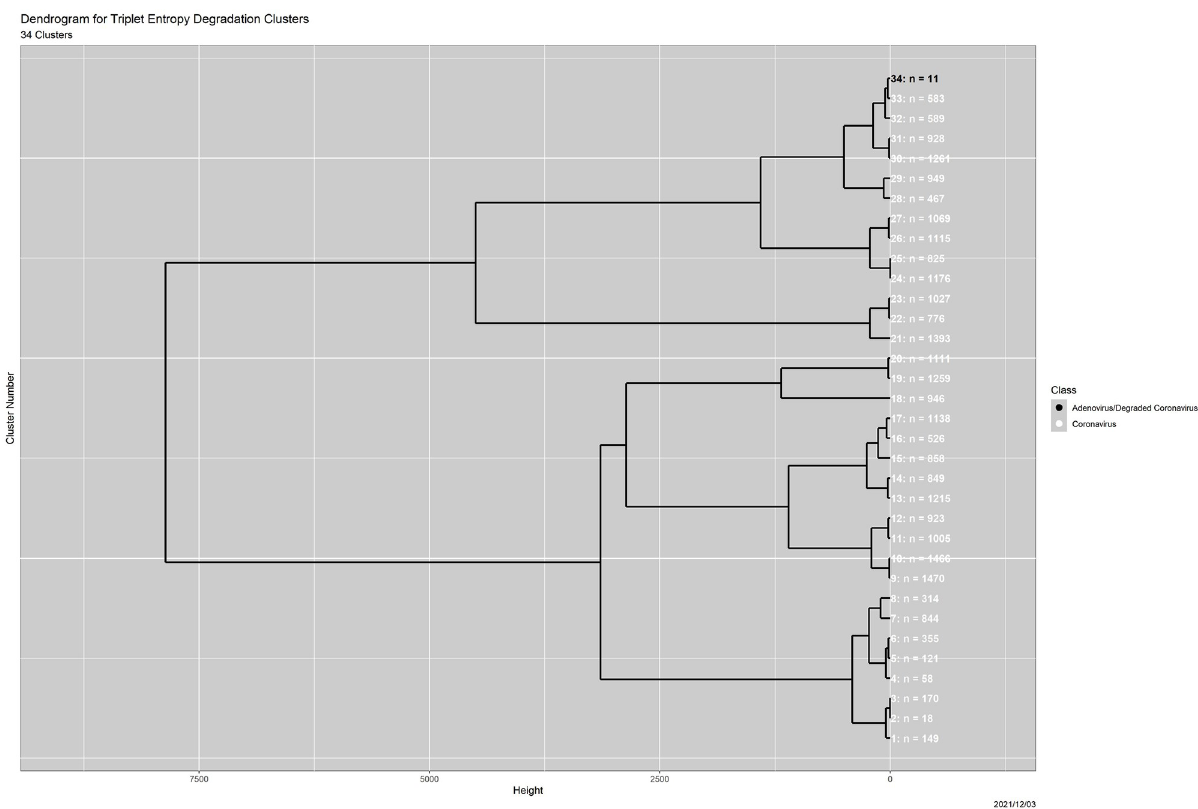
Fig 9. Results for triplet entropy clustering. Dendrogram, in which clusters are in order from 1 at the bottom to 34 at the top. Colors are the same as in Fig 8.